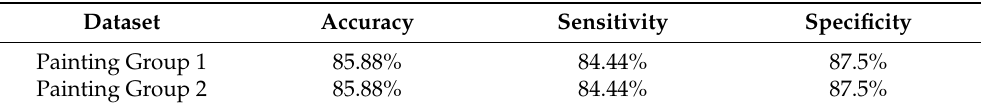
movement features.